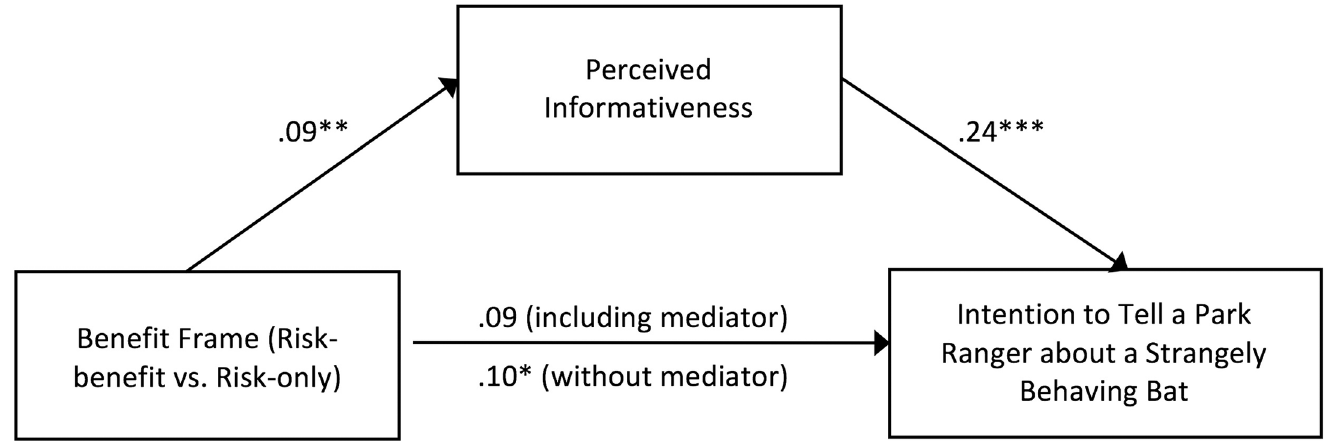
Fig 1. Mediation analysis investigating the relationship between benefit frame, perceived informativeness, and intention to tell a park ranger about a strangely behaving bat. Note: Total indirect effect = .02 (95% confidence interval = .01, .05). The uncertainty frame and the interaction term between the benefit frame and the uncertainty frame are not shown to reduce visual clutter. * p < .05; ** p < .01; *** p < .001.